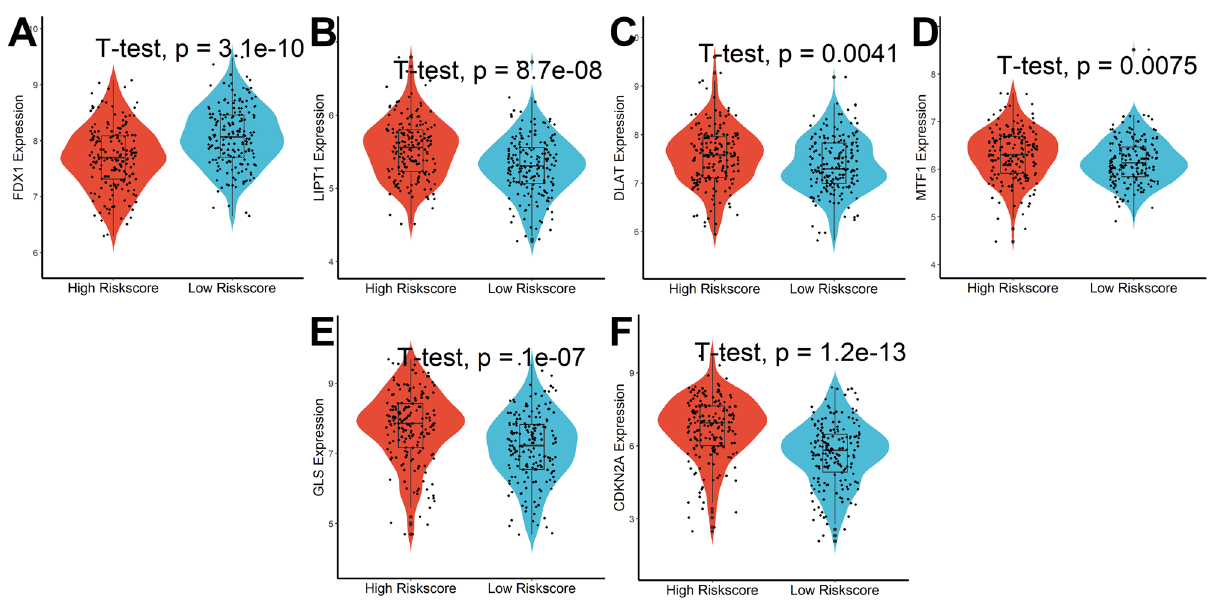
Figure 6. Analysis of differences in Cuproptosis-related genes between patients in high- and low-risk score groups. ( A ) FDX1, ( B ) LIPT1, ( C ) DLAT, ( D ) MTF1, ( E ) GLS, and ( F )